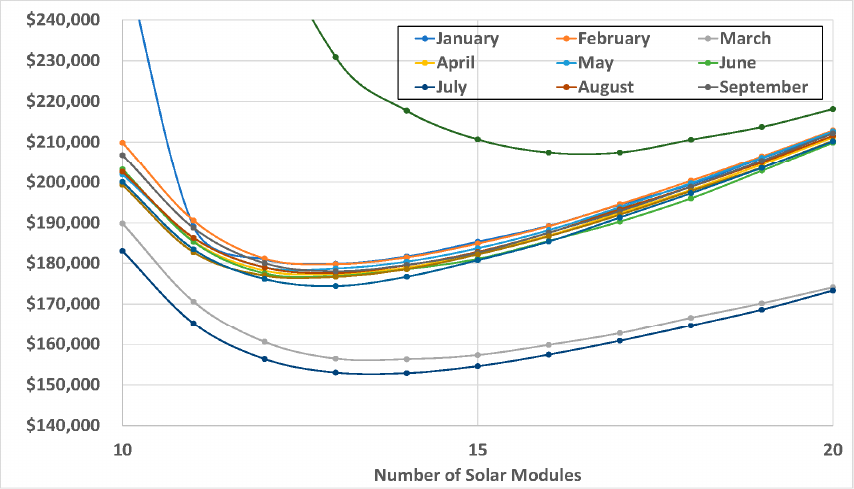
Figure 5. Variable starting month for IES given 10% initial charge, five systems, San Antonio, and 0.1% LPSP.